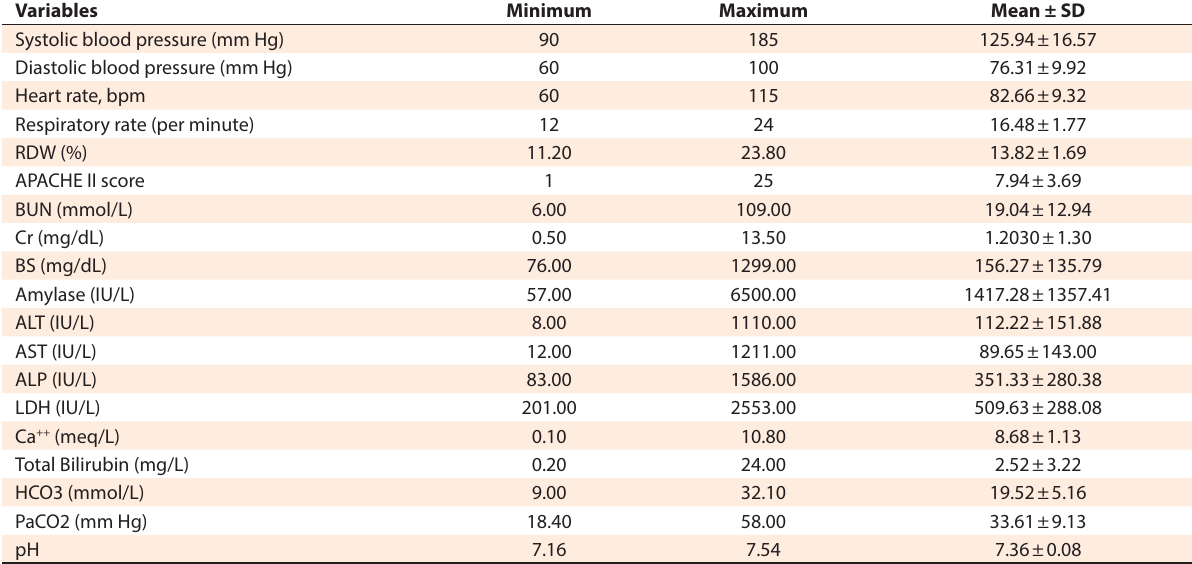
Table 1. Vital signs and paraclinical findings of the patients Variables